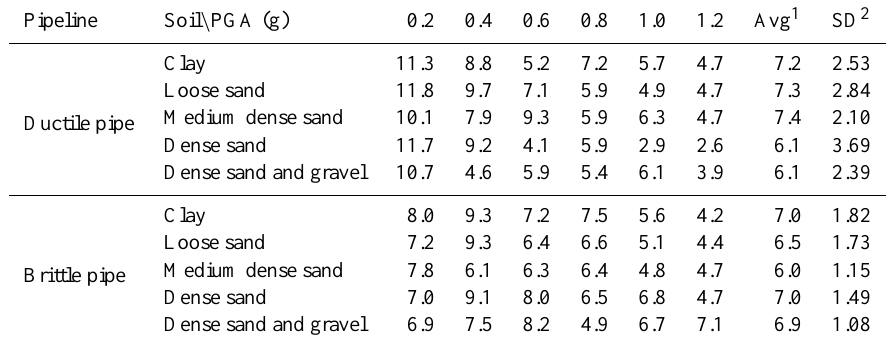
Table 7. Mobilized stress difference (%) of pipeline modeled based on Korea and US design criteria and construction specification. Pipeline